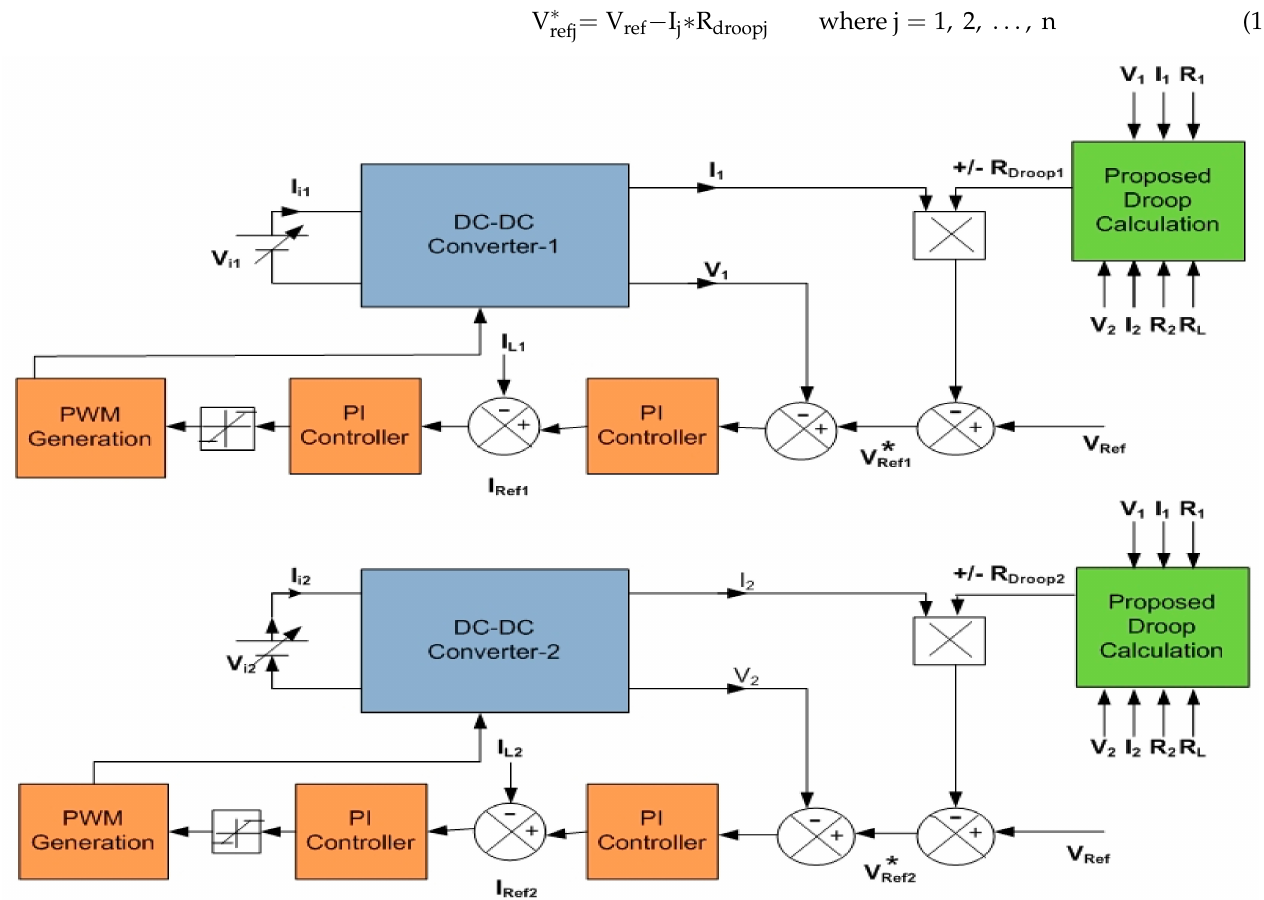
Figure 4. Control diagram of parallel converters with R droop